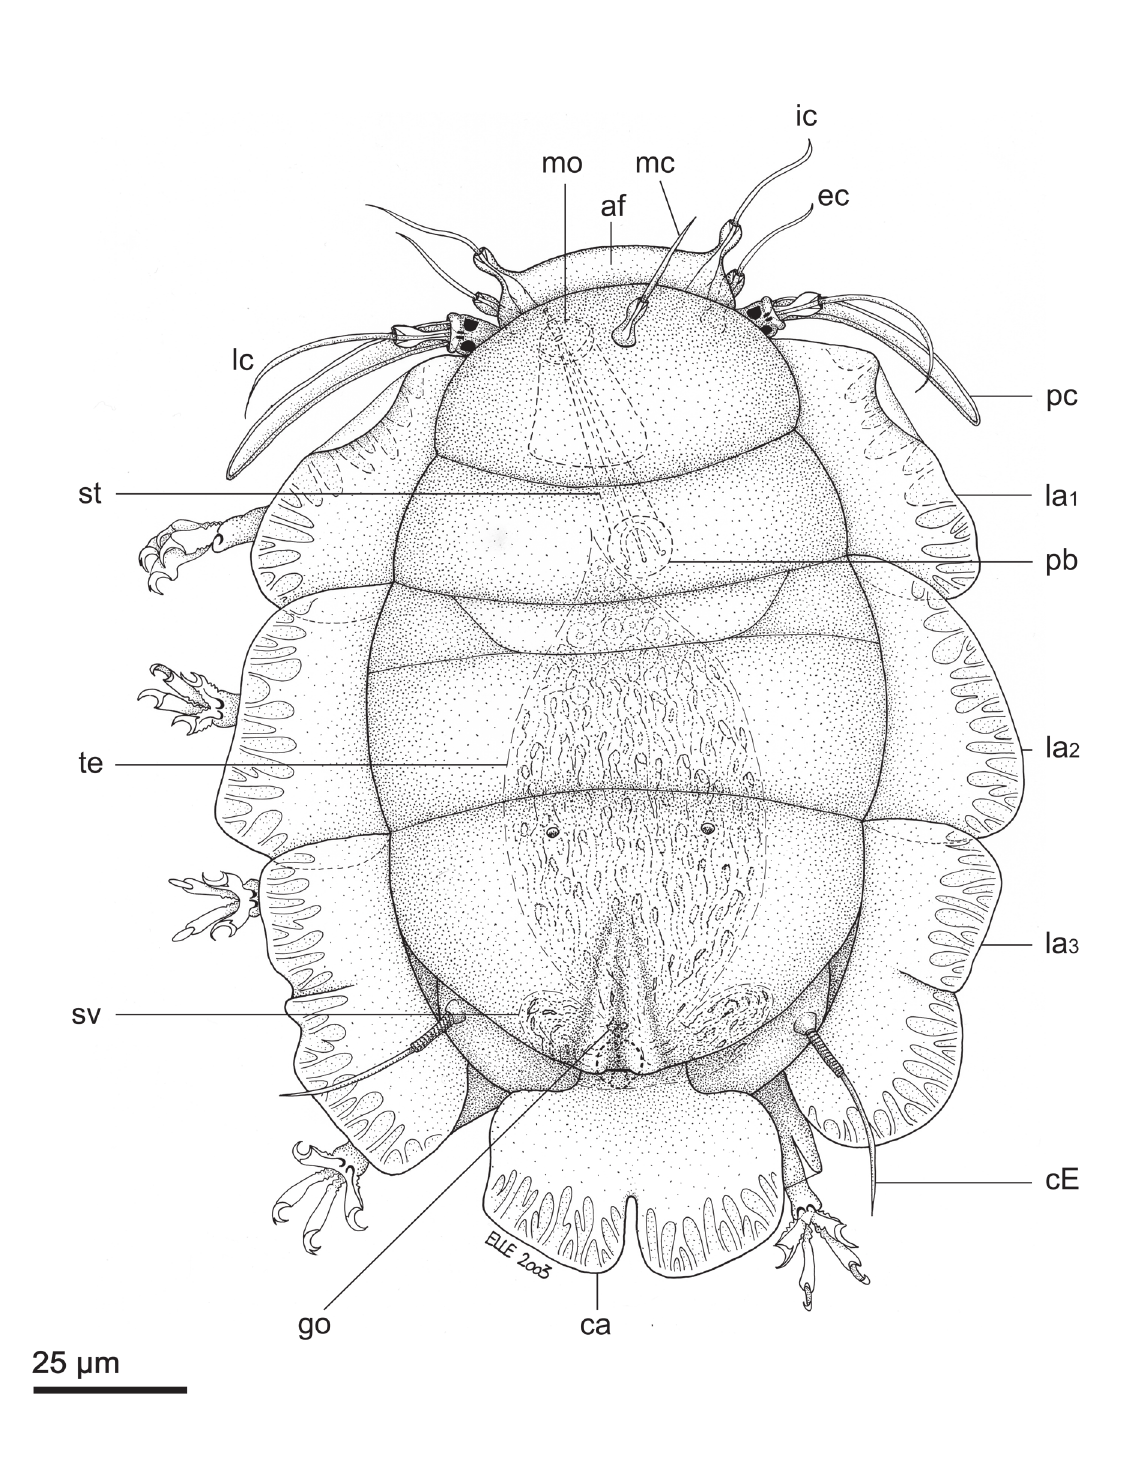
Fig. 6. Higginsarctus signeae gen. et sp. nov., allotype, ♂ (NHMD-293900). Dorsal overview. Abbreviations: see Material and methods. Drawing by Stine B.